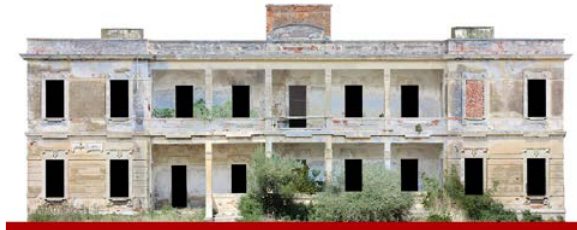
Figure 12. View of the complex